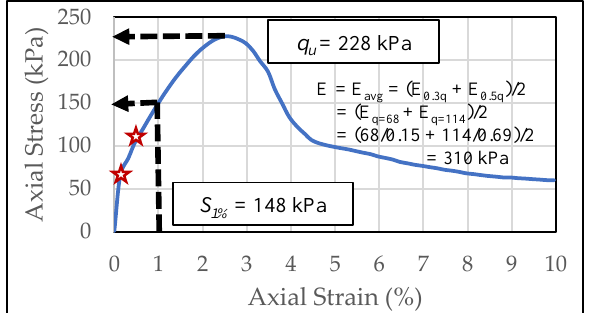
Figure 3. Quick shear (QS) Test Results.